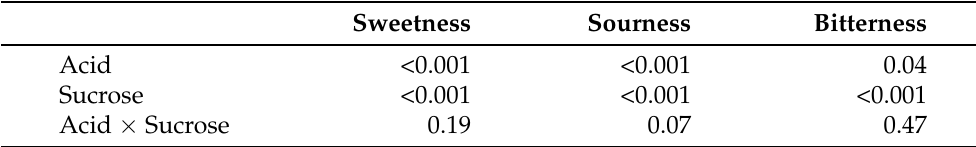
Table 6. p -values for ANOVA model of coffee matrix.